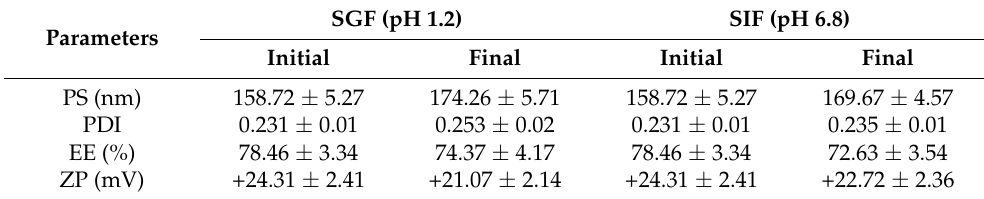
Table 5. Stability of PPN-LPHNPs in SGF (pH 1.2) and SIF (pH 6.8).